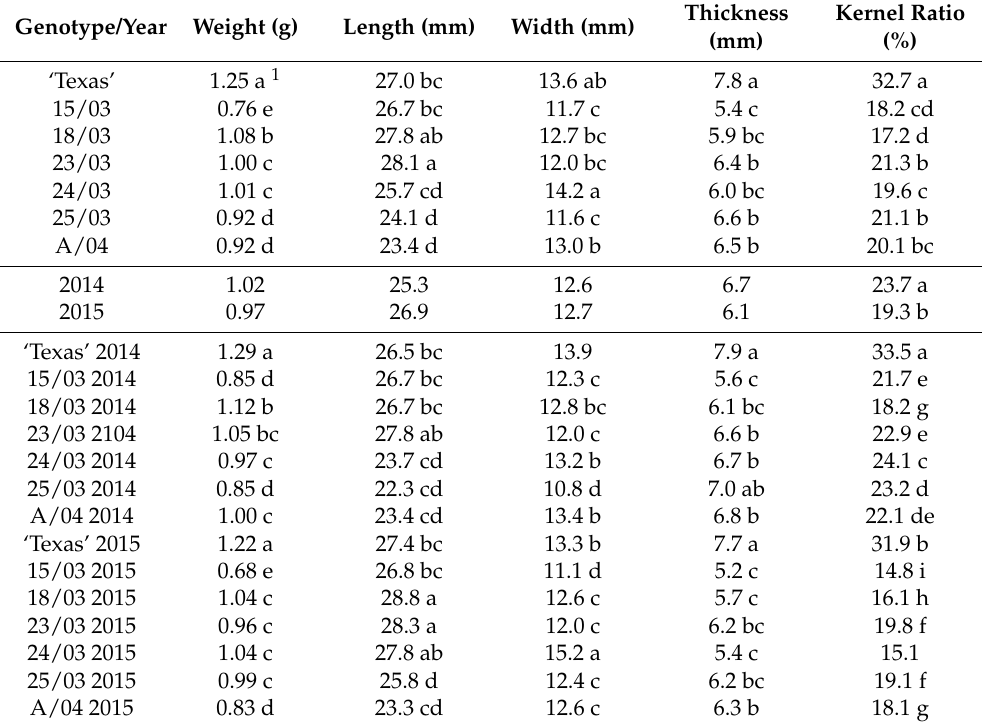
Table 3. The kernel morphological